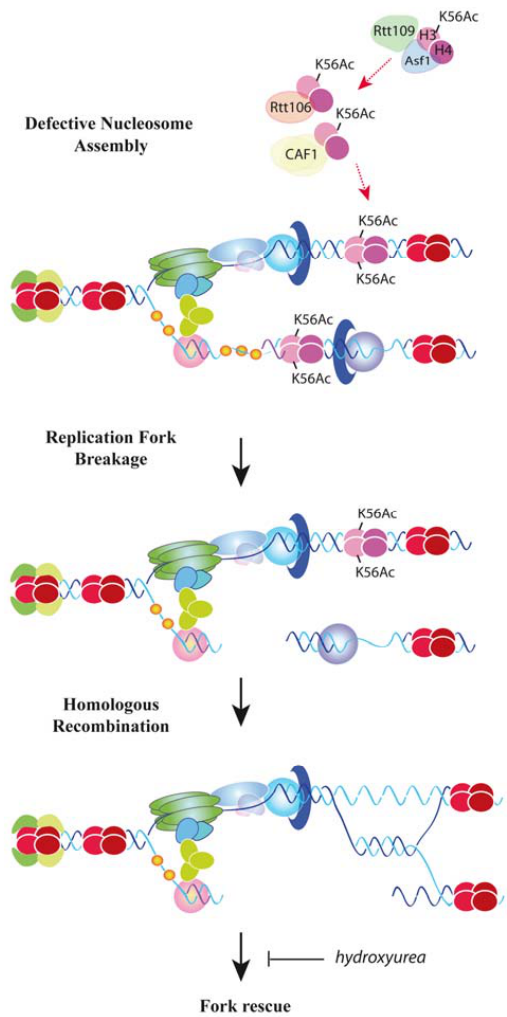
Figure 2. Replication fork stability by chromatin assembly. Defective nucleosome assembly in yeast by a deficit in the pool of newly synthesized histones, or a lack of the H3K56Ac/CAF1/Rtt106 histone deposition pathway (symbolized by a dashed red arrow) causes replication fork breakage and its rescue by homologous recombination [118,119]. Uncoupling DNA synthesis from histone deposition might expose ssDNA fragments to nucleases, impair the process of Okazaki fragment maturation or alter the correct distribution of cohesins, leading to DNA breaks.